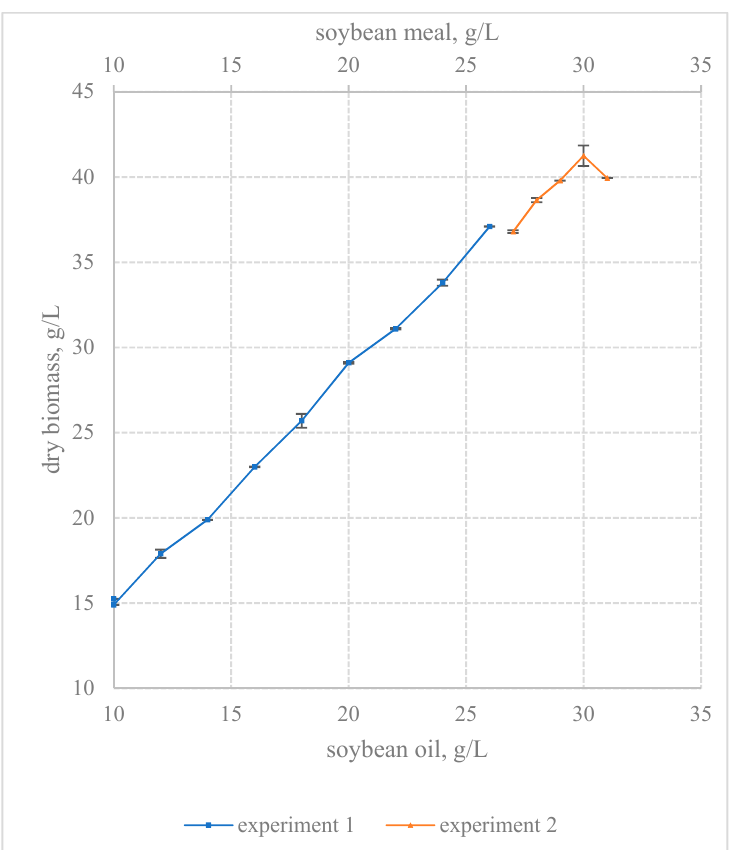
Figure 4. Steep ascent experiments. The yield of F. velutipes biomass with increasing concentrations of soybean oil and soybean meal in the nutrient medium.